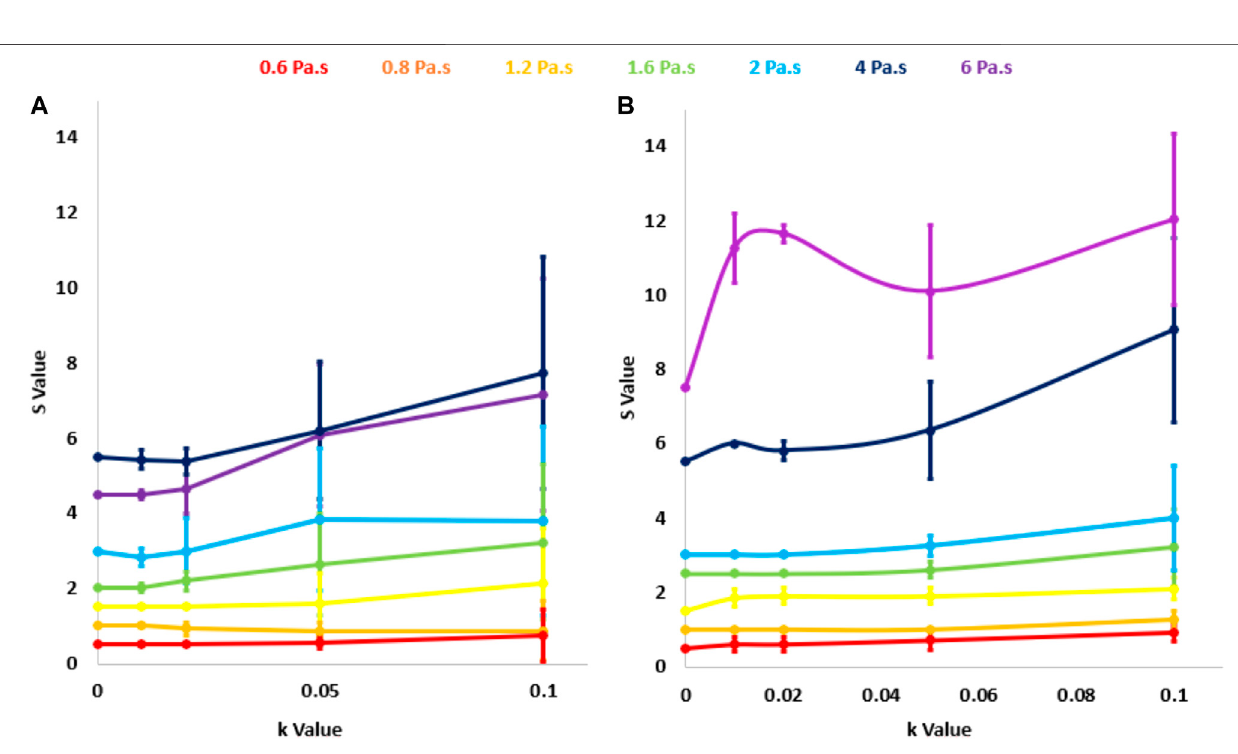
Frontiers in Physics |